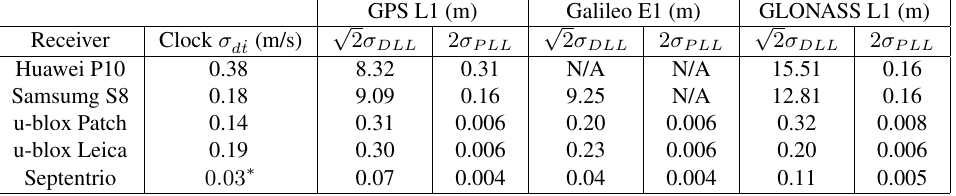
Table 1: Table for the measured error model parameters for different GNSS receivers in open sky conditions, reproduced from [Lehtola et al., 2019b].